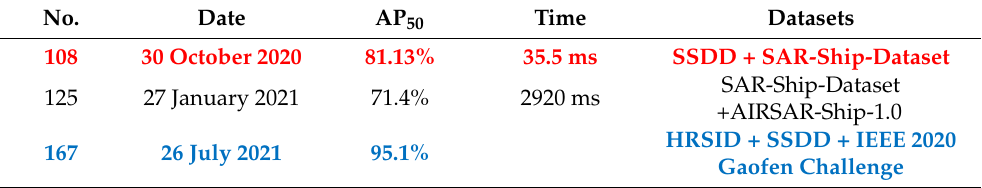
Table 11. The performance evolution of detectors on other datasets (the data come from the 177 papers).